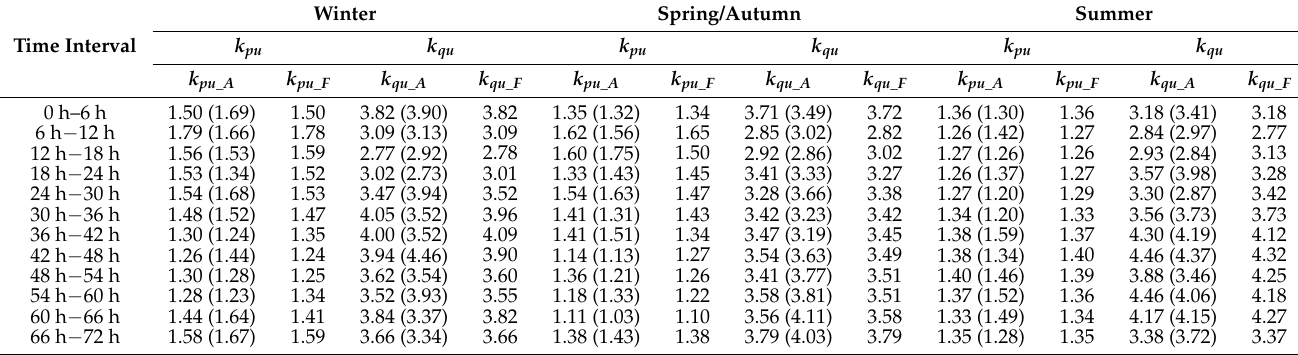
Table 3. Average k pu and k qu values in 6 h time intervals during three days ( k pu_A and k qu_A ), and corresponding k pu and k qu values from fitting curves ( k pu_F and k qu_F ), in three seasons. Time Interval